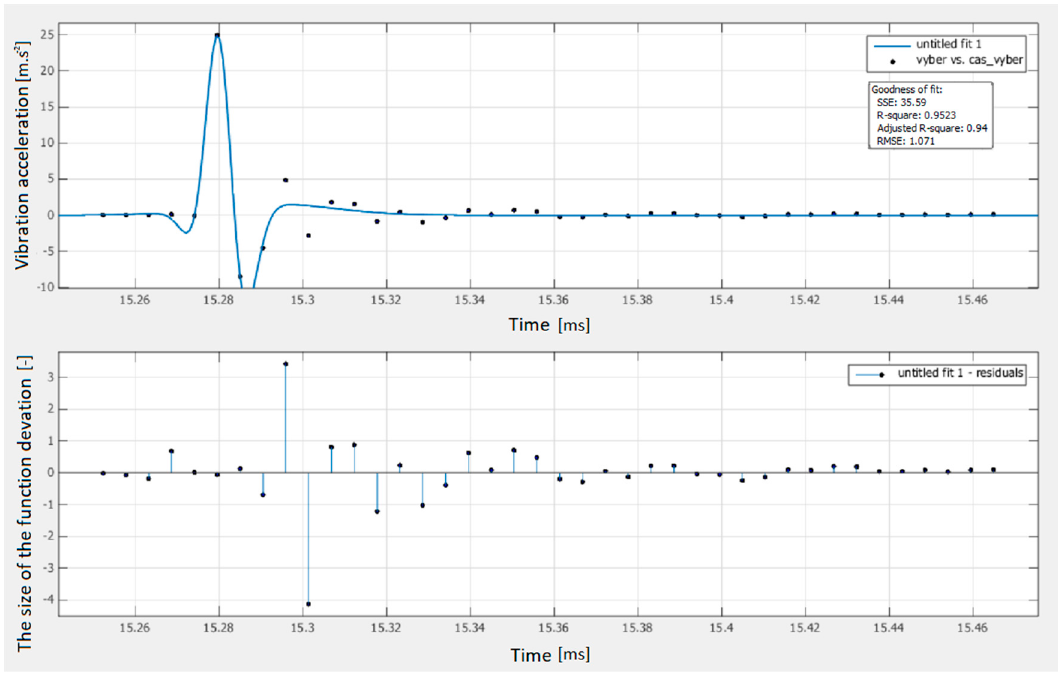
Figure 15. Gaussian regression curve.